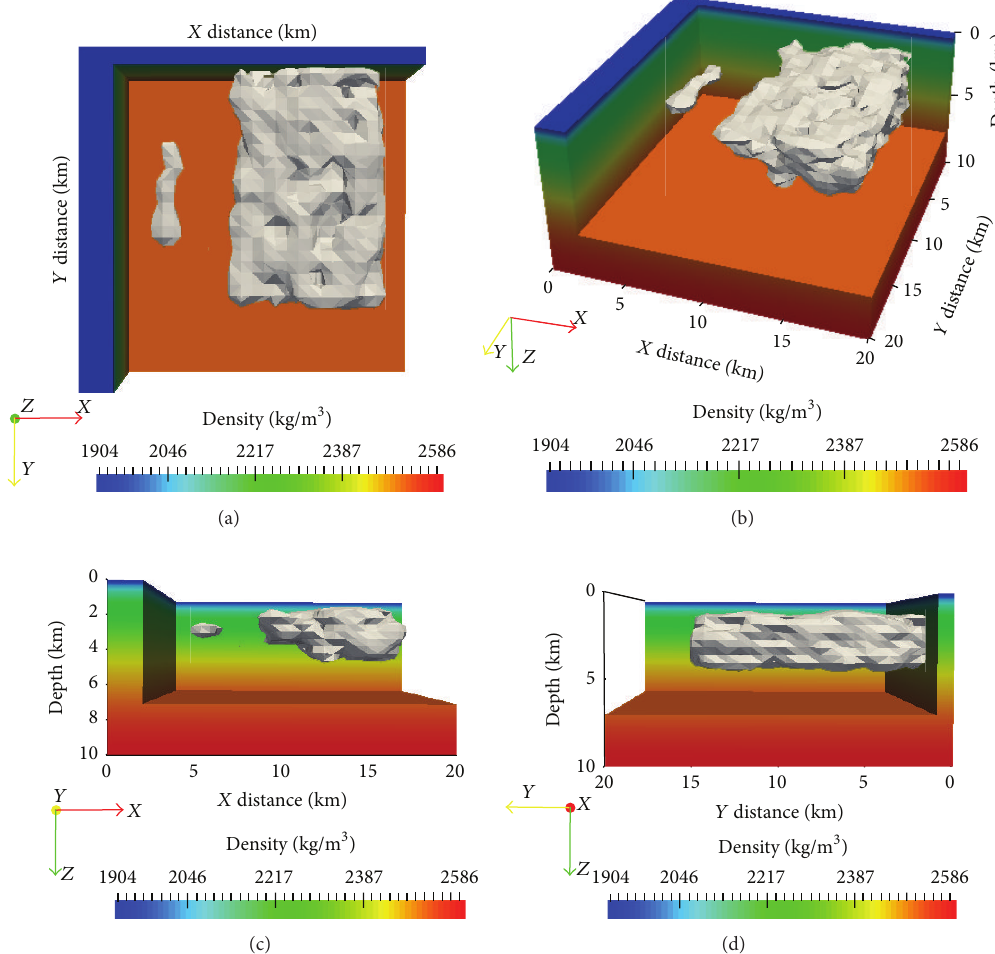
Figure 8: 3D initial model built from 3D Euler deconvolution solutions and the maxima of the lateral extent estimation methods previously applied to the gravity anomaly.